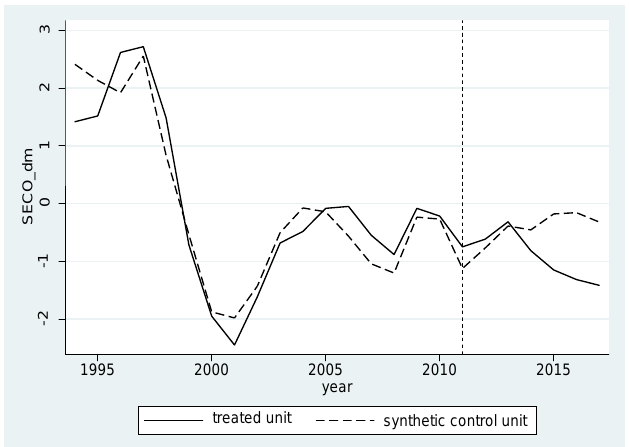
Figure 11. Outcome specification